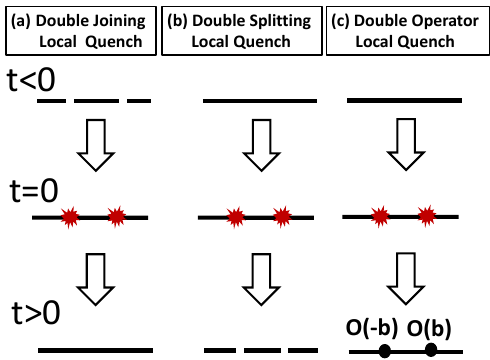
Figure 1 . The three di(cid:11)erent double local quenches are sketched: the joining local quench ((a): left), the splitting local quench ((b): middle), and the operator local quench ((c): right) in two dimensional CFTs. We choose the two points where the local quench occurs to be x =